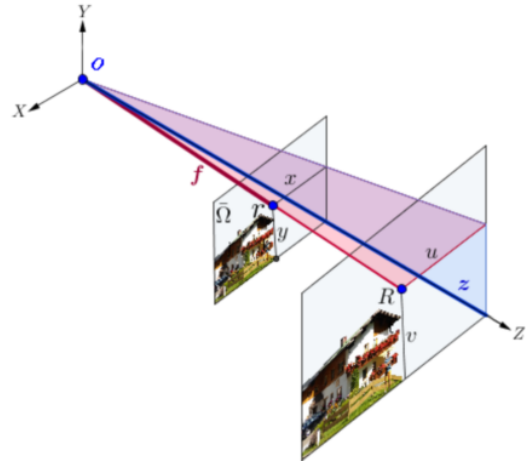
Fig. 3 Perspective projection of the real point R into the image plane ¯Ω.